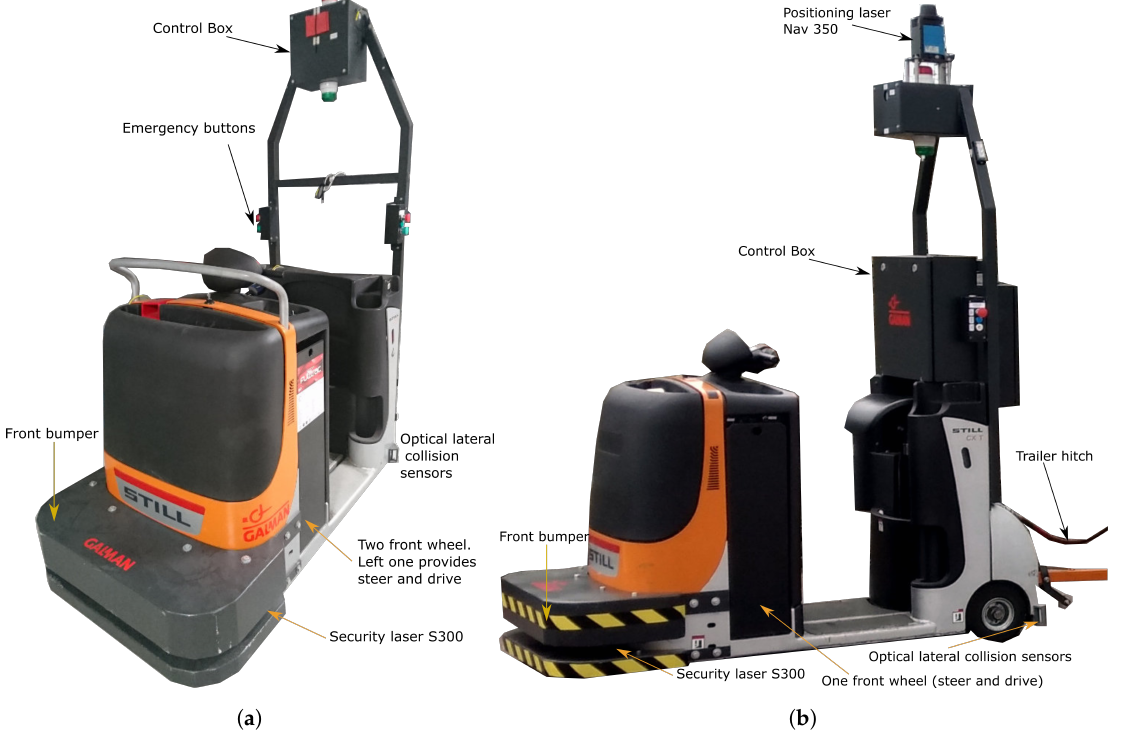
Figure 1. Vehicles used in this research: ( a ) quadricycle tugger; ( b ) tricycle